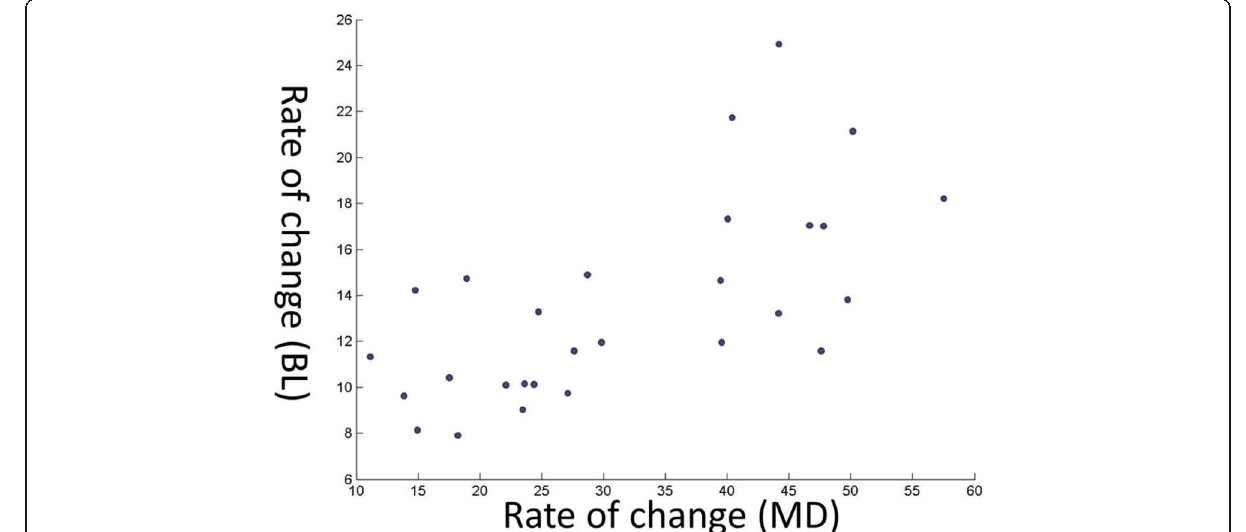
Fig. 4 Relation between BL and MD